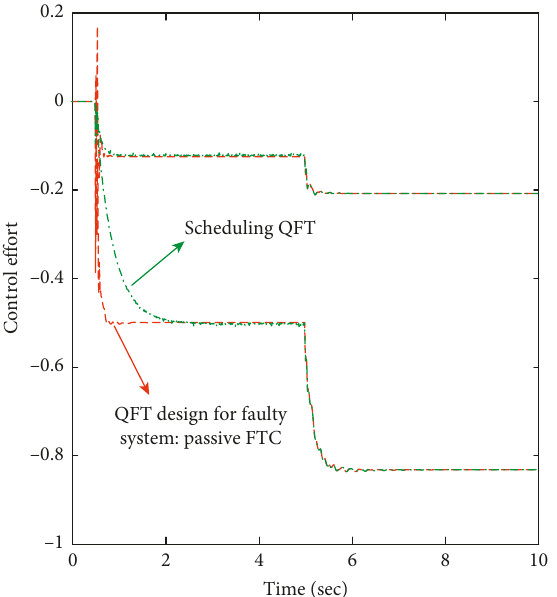
Figure 9: Control envelope for the fixed fault case using the passive FTC and the proposed scheduling design.